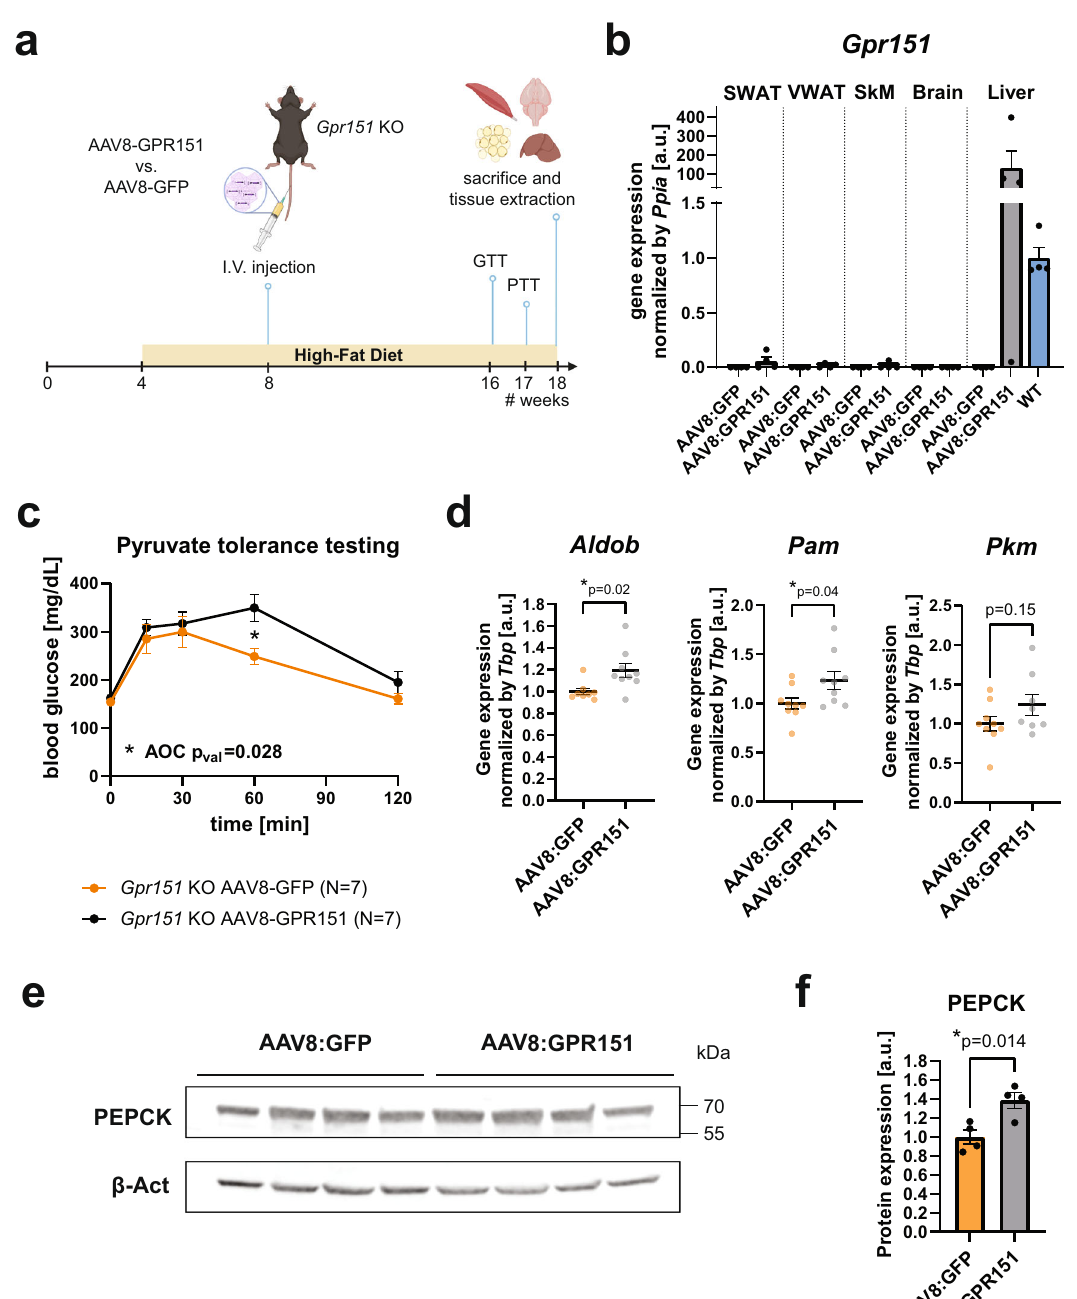
Fig.6 |Overexpressionof Gpr151 intheliverofDIO Gpr151 KOmicerescuesthe downregulation of hepatic gluconeogenesis gene expression. a Schematic of theexperimentsinvolvingliveroverexpressionof Gpr151 usingAAV8,createdusing Biorender. b Quanti fi cationof Gpr151 overexpressionbyRT-qPCRin subcutaneous (SWAT) and visceral (VWAT) adipose tissue, skeletal muscle (SkM), brain and liver of Gpr151 KOmiceinjectedeitherwithAAV8-GFPorAAV8-GPR151.Datanormalized to Gpr151 expression in the livers of age-, sex- and diet-matched wild-type mice ( N =4, Gpr151 KO AAV8:GFP; N =4, Gpr151 KO AAV8:GPR151). Data are represented as mean values + SEM. c Blood glucose levels in Gpr151 KO DIO mice injected with AAV8-GPR151 or AAV8-GFP, subjected to pyruvate tolerance testing. Data are representedasmeanvalues±SEM.AOCcomparedusingtwo-tailedStudent ’ s t test. Two-tailed Student ’ s t test with Bonferroni correction used to test differences at every time point (* t =60 q val =0.049; N =7 Gpr151 KO AAV8:GFP; N =7, Gpr151 KO